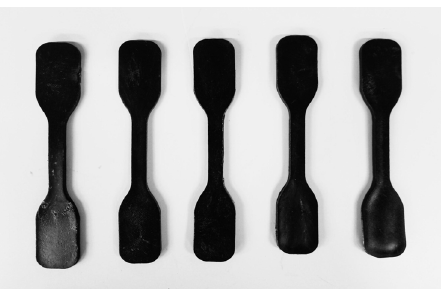
Figure 2. 30 wt. % PP-lignin ASTM D638 Type IV tensile test coupons.